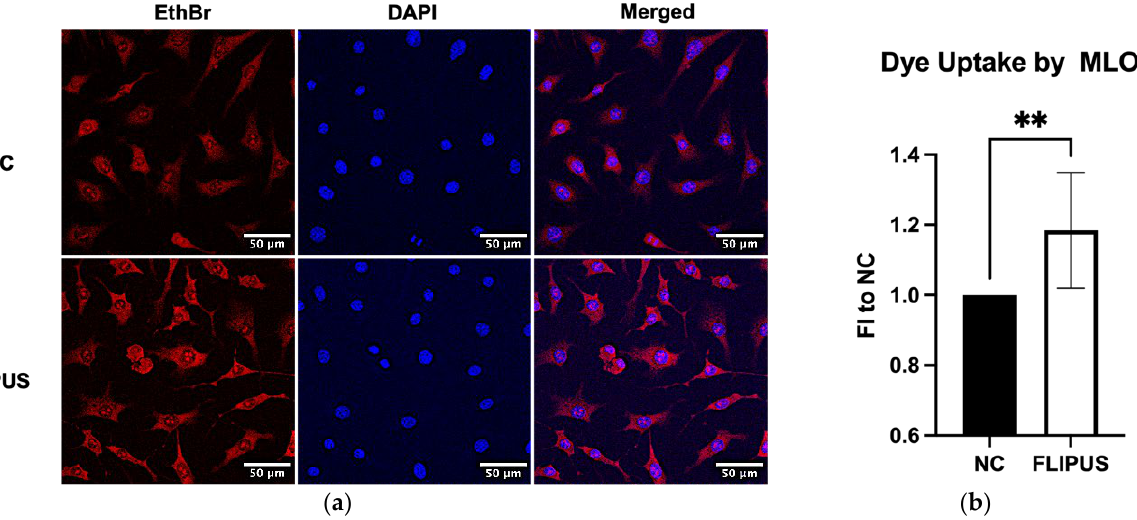
Figure 6. Ten-minute FLIPUS exposure of starved MLO-Y4 osteocytes enhances dye uptake by the cells. ( a ) Representative images of the ethidium bromide (EthBr) dye uptake; ( b ) Quantification results of the dye uptake assay. FI to NC stands for fold induction over negative control, which did not receive ultrasound treatment. Each data point was the result of N = 3 and n = 2, where N and n are biological trials and technical replicates, respectively. Five random pictures were analyzed for each data point. ** represents p ≤ 0.01.